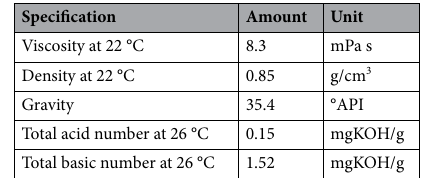
Table 1. Specifications of crude